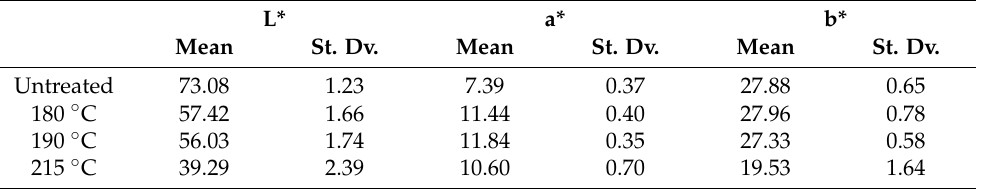
Table 3. CIELab colour coordinates of heat-treated ayous wood.